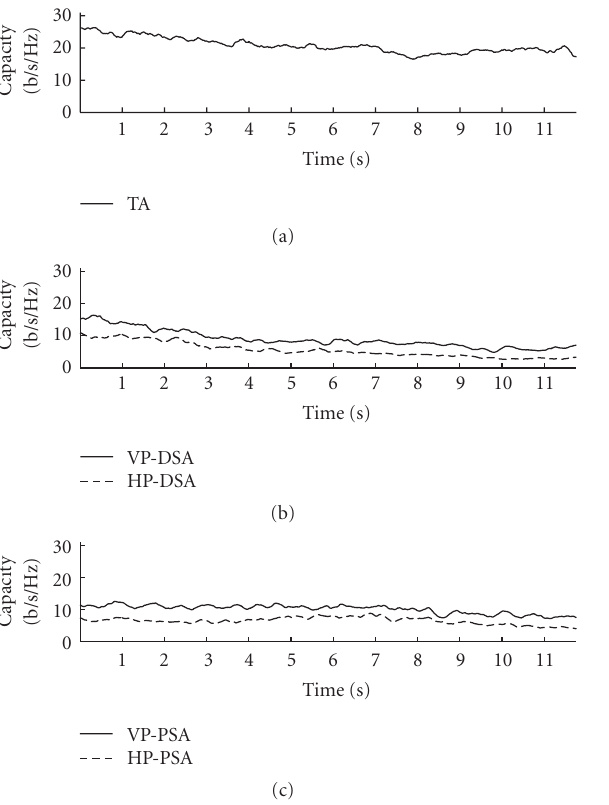
Figure 15: Capacity estimated at each array position on Kent